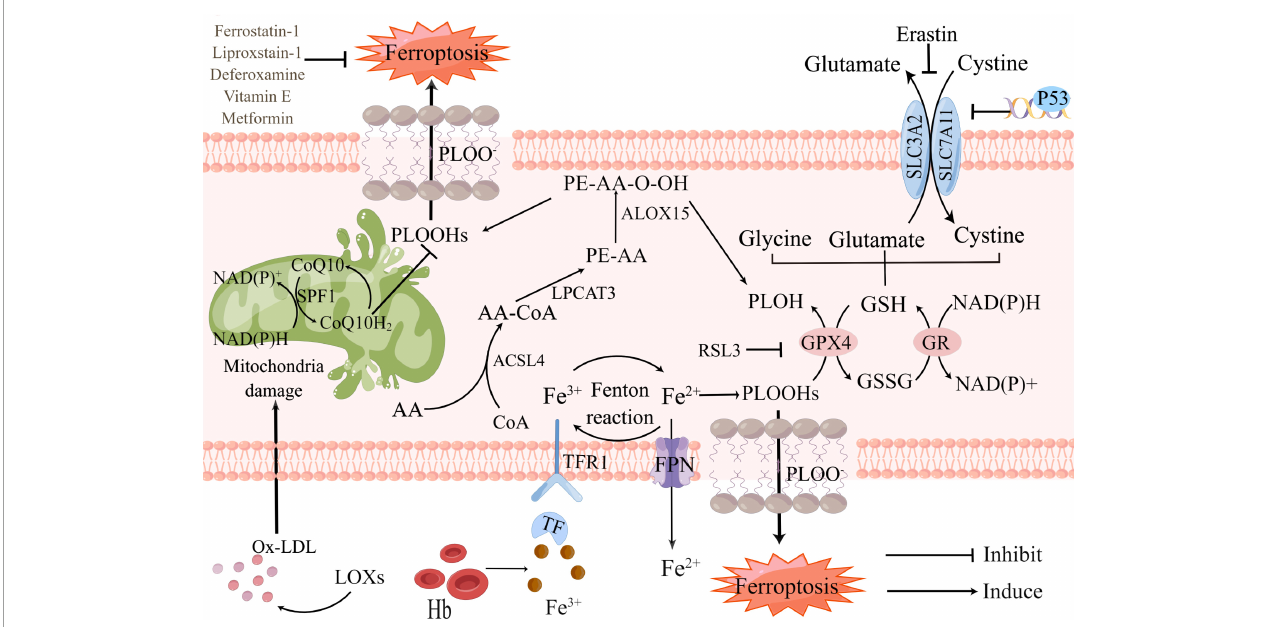
FIGURE1 Core mechanisms and signaling pathways of ferroptosis in Intracerebral hemorrhage (ICH). Ferroptosis is driven by the accumulation of PLOOHs, which is tightly linked to the metabolism of amino acids, iron, and lipids. Iron overload and antioxidants lacking as the major component of lipid peroxidation, which contribute to ferroptosis. Fe3+, released from hemoglobin after ICH, converts into Fe2+ by Fenton reaction. Too much Fe2+ causes iron overload in neurons, accelerating intracellular reactive oxygen species (ROS) production and promoting ferroptosis. GSH-GPX4 and FSP1-CoQ are the two main pathways against ferroptosis. Restriction of either pathway will promote ferroptosis. PLOH, phospholipid alcohol; PLOOHs, phospholipid hydroperoxides; FSP1, ferroptosis suppressor protein 1; CoQ10, coenzyme Q10; CoQ10H2, ubiquinol-10; Ox-LDL, oxidized low-density lipoprotein; LOXs, lipoxygenases; Hb, hemoglobin; Fe3+, ferric iron; Fe2+, ferrous iron; ACSL4, Acyl-CoA synthase long-chain family member 4; AA-CoA, arachidonoyl-CoA; LPCAT3, lysophosphatidylcholine acyltransferase 3; FPN, ferroportin; RSL3, RAS-selective lethal 3; GPX4, glutathione peroxidase 4; GSH, glutathione; GSSG, glutathione disulfide; GR, glutathione reductase; ALOX15, arachidonate 15-lipoxygenase; SLC3A2, solute carrier family 3 member 2; SLC7A11, solute carrier family 7 member